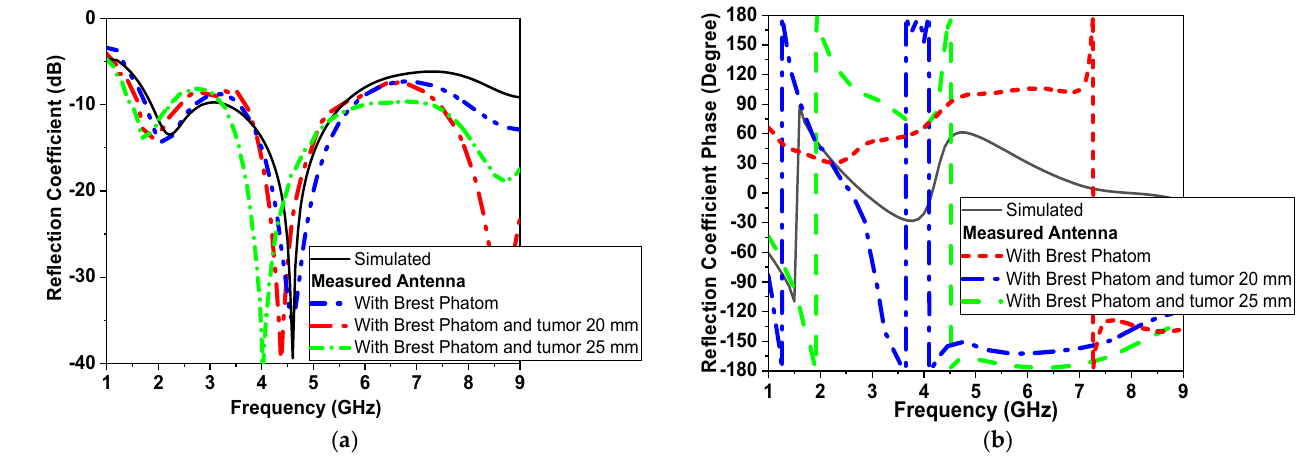
Figure 21. Measured |S 11 | of sensor with breast and tumor models ( a ) magnitude and ( b ) phase.